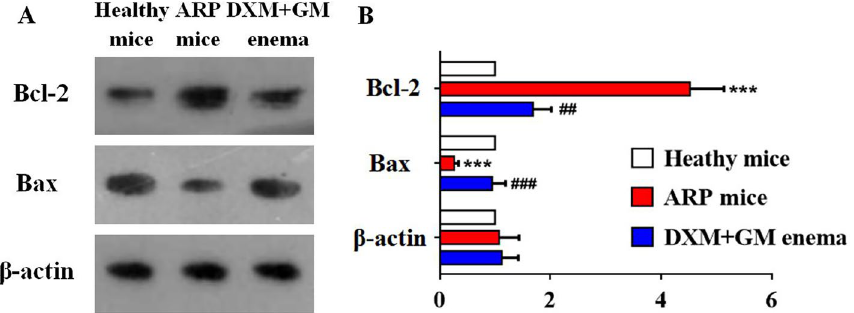
Figure 9. DXM + GM enema leads to apoptosis in ARP mice. ( A ) The expression levels of Bcl-2 and Bax protein in rectal tissues of ARP mice treated by DXM + GM enema using western blot. ( B ) The expression of Bcl-2 was increased while the expression of Bax was decreased in ARP mice (*** P < 0.001). DXM + GM enema significantly decreased Bcl-2 expression and increased Bax expression in rectal tissues of ARP mice ( ## P < 0.05, ### P <